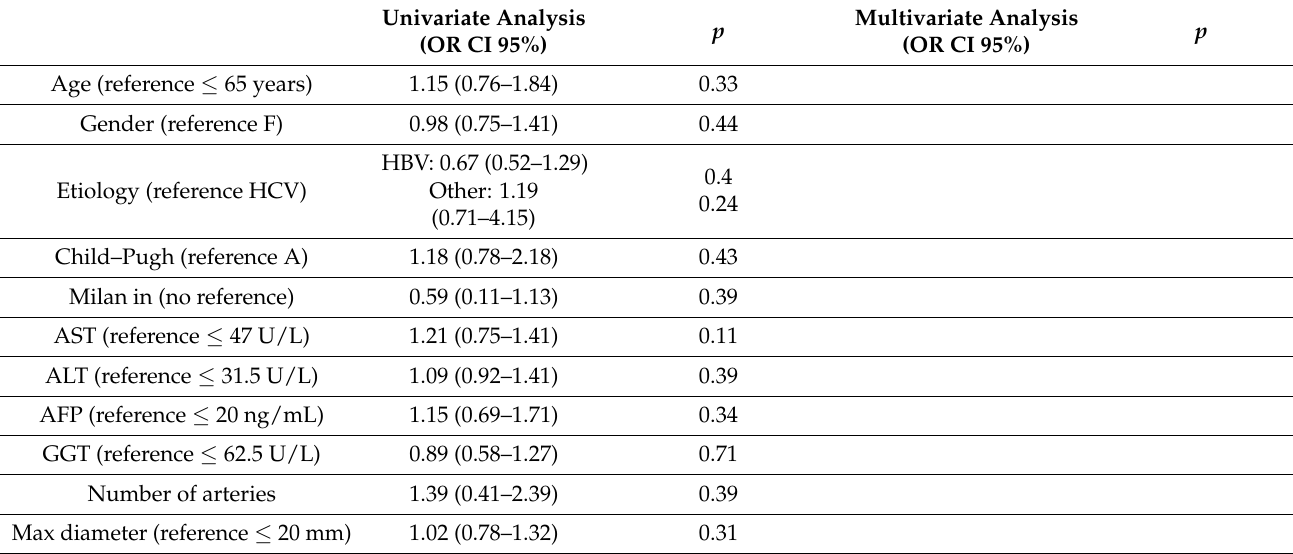
Table 4. Univariate and multivariate logistic regression analyses for the assessment of clinical, laboratory, and procedural data associated with the complete response of the target